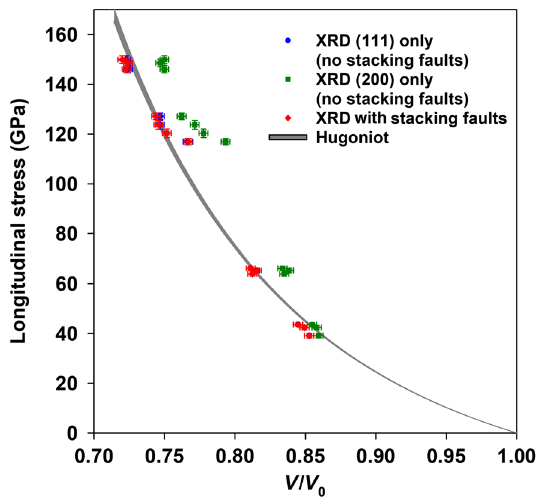
FIG. 3. Stress-volume states of shock-compressed gold. Stresses are calculated from velocity interferometry data. Unit cell volumes are calculated from a 3 , where the lattice constant a is determined directly from a fit to the (111) diffraction peak (blue circles) or the (200) diffraction peak (green squares), without considering the effects of stacking faults. The red diamonds are from a combined fit of the full diffraction profile, comprising all five peaks, that incorporates shifting and broadening of the diffraction peaks due to stacking faults. The gray band is the Hugoniot curve for gold, determined from continuum measure- ments (Refs. [7,19,20]; see SM [41]); the width of the band indicates the experimental